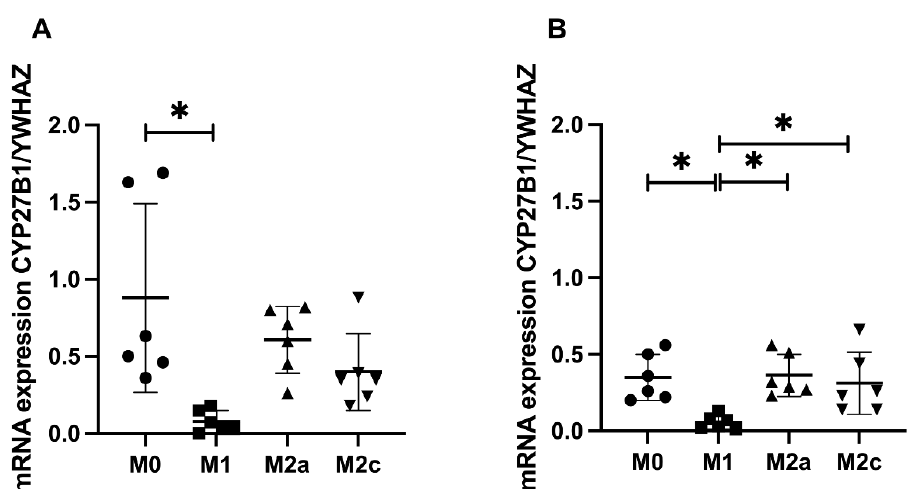
Figure 3. Expression of CYP27B1 in polarized MDMs with and without vitamin D stimulation. MDMs were polarized into M0, M1, M2a and M2c MDMs and stimulated with either 0 nM ( A ) or 1000 nM ( B ) 25-hydroxy-vitamin D for 24 h. The mRNA expression of CYP27B1 is shown relative to the household gene ( YWHAZ ). * Indicates a statistically significant difference between groups.